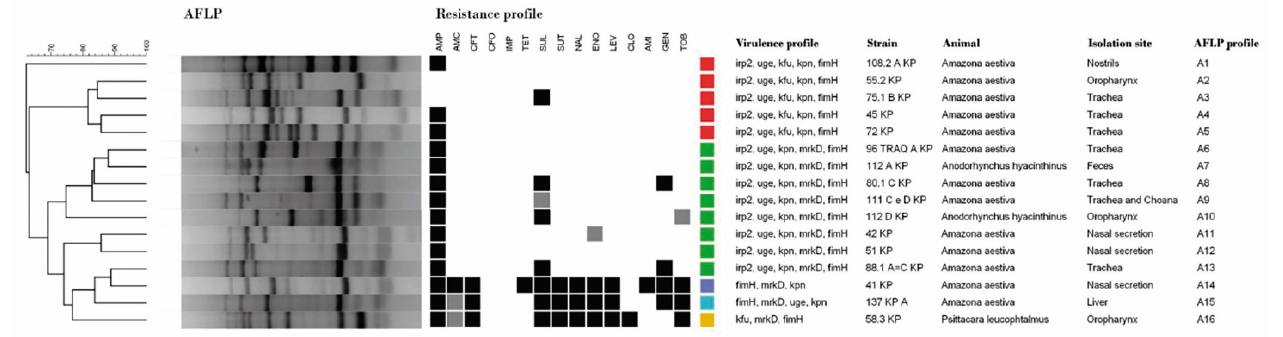
Figure 1. Dendogram showing the relationship among the SE-AFLP patterns of K. pneumoniae isolated from companion birds. Table 1. Characteristics and genomic data of K . pneumoniae strains infecting companion